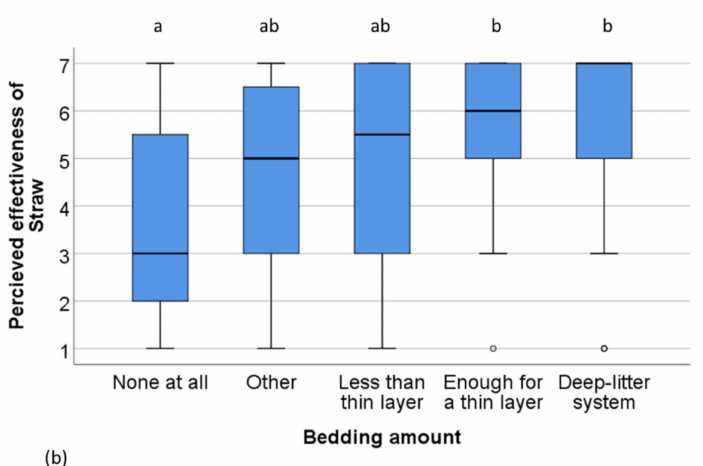
Figure 3. Scoring of the e ff ectiveness of Straw as a manipulable material to prevent tail biting on ( a ) farms which rear pigs with di ff erent proportions of the tails removed ( n = 155) and ( b ) farms using di ff erent bedding amounts ( n = 162). Scale: 1 (not e ff ective) to 7 (extremely e ff ective). The boxplot indicates medians and quartiles (25% and 50%) as well as outliers. Boxes lacking common letters di ff er ( p <